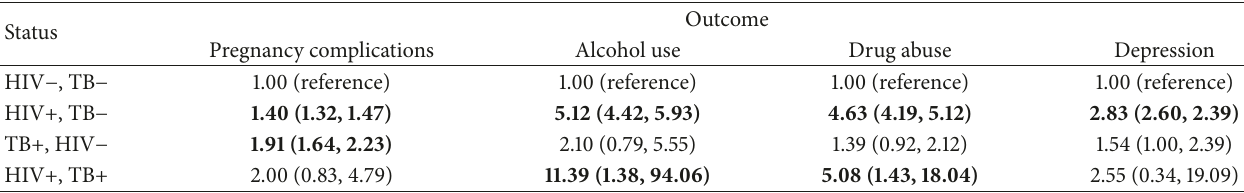
Table 3: Adjusted odds ratios for the association between HIV infection, TB disease, and HIV-TB coinfection status and obstetrics complications, alcohol abuse, drug abuse, and mental health among pregnancy-related admissions in the Unites